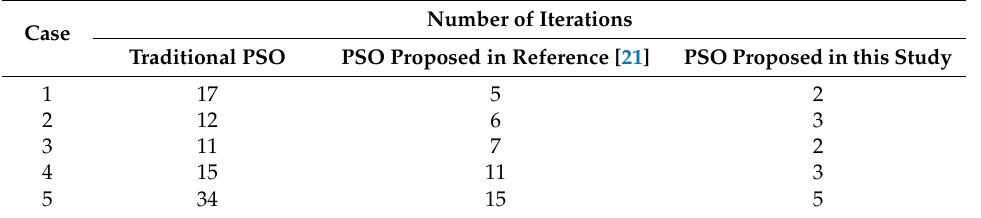
Table 5. Number of iterations for various optimization methods to obtain the optimal values for the five cases.